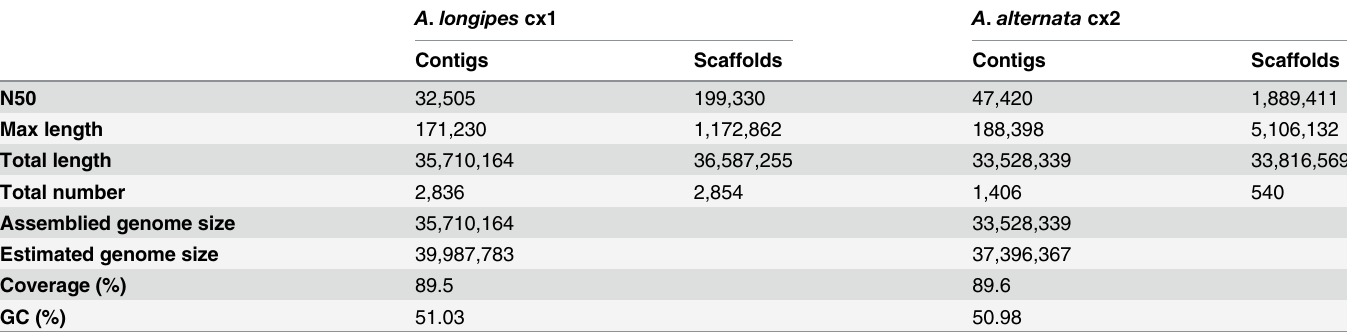
Table 1. Statistics for the assembled genome sequences of A . longipes cx1 and A . alternata